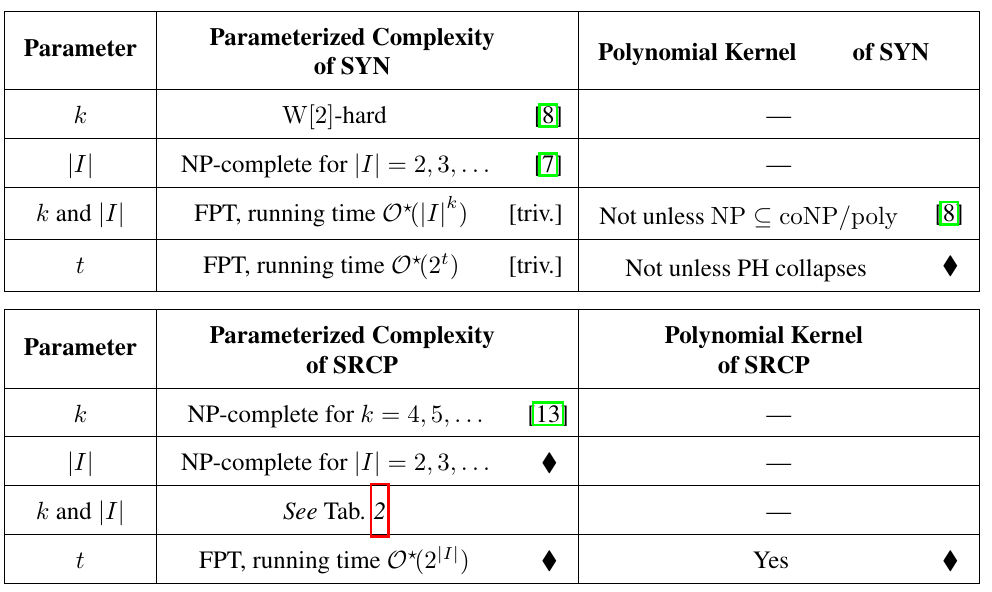
Tab. 1: Results of the complete multi-parameter analysis of SYN and SRCP. Diamonds mark the results of the present